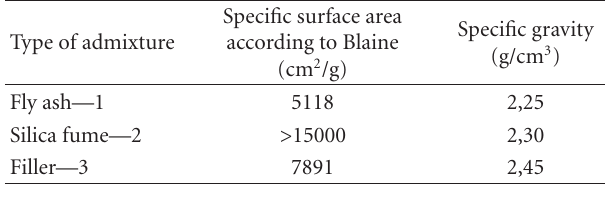
Table 1: Admixtures’ characteristics.